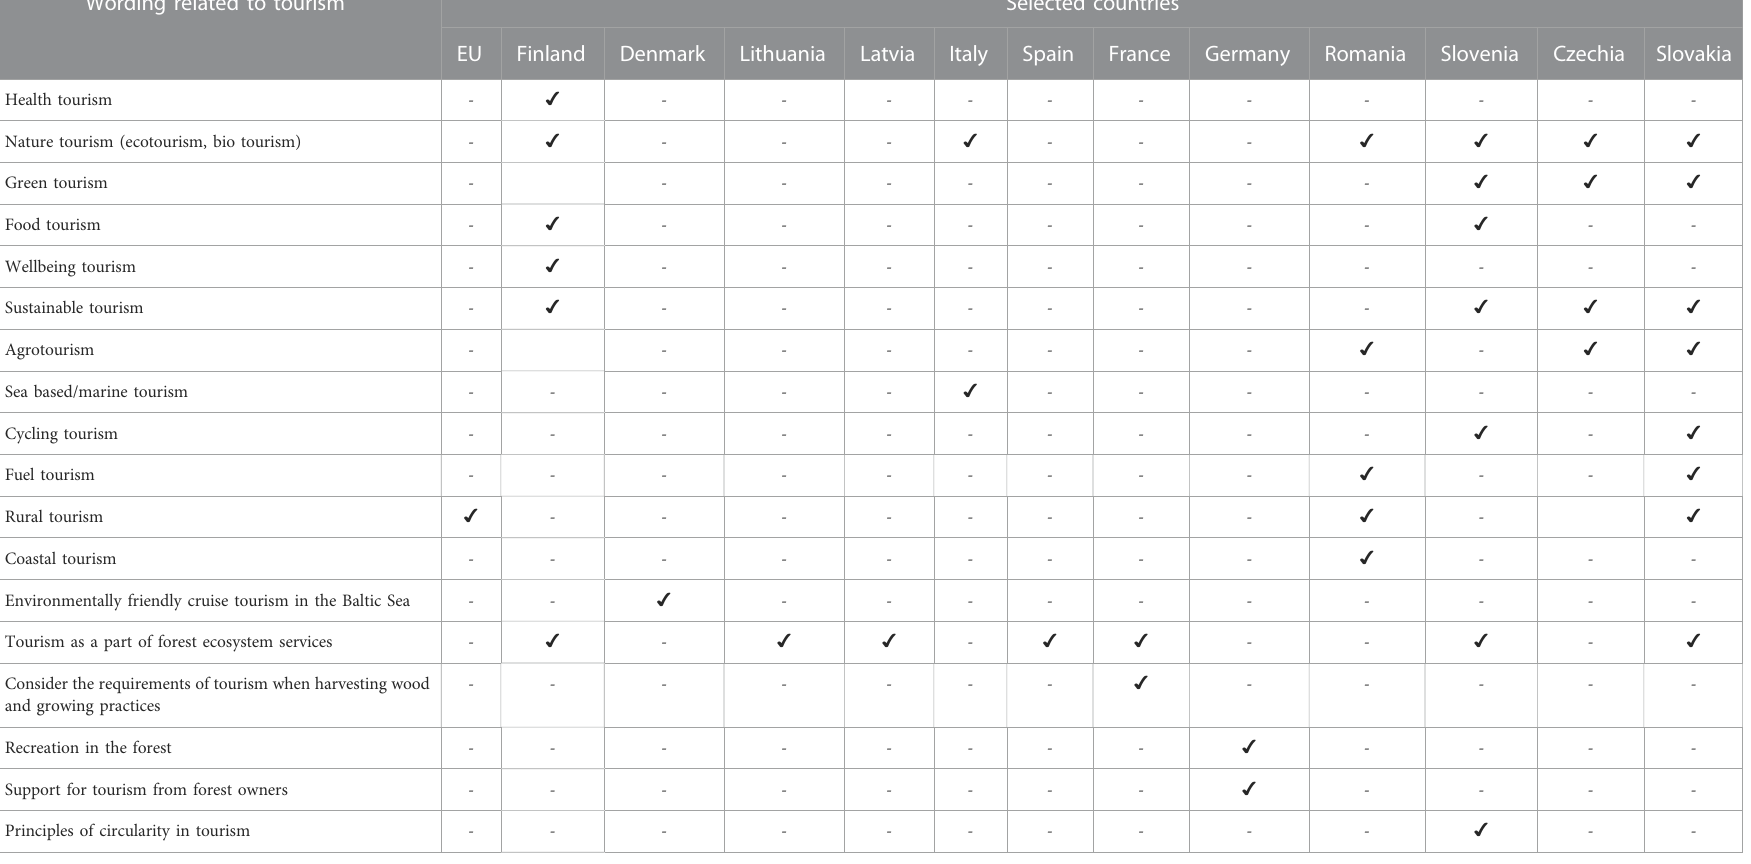
TABLE 2 Wording related to tourism in selected